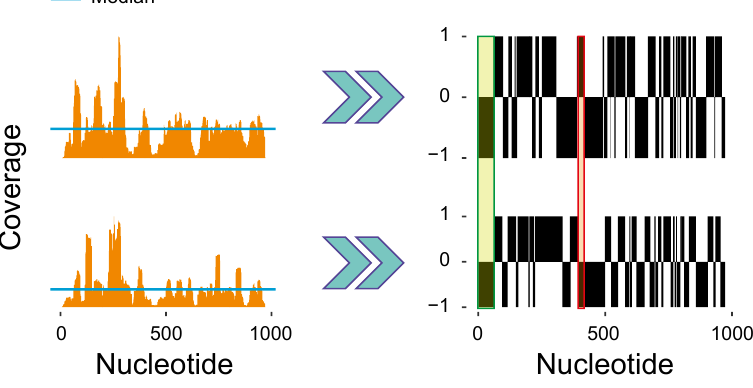
Figure 2. Pairwise comparison of two Ribo–seq profiles of the ispB gene. Two independent Ribo–seq profiles (left) are obtained by computing the coverage at each nucleotide position within the ORF. x-axis: position within the ORF (nucleotides); y-axis (top): relative coverage (number of mapping reads/total number of reads) mapping on the ORF. The Ribo–seq profiles are compared to the median coverage to produce the digitalized ± 1 profiles (right). The digitalized profiles can be easily compared to detect matches (e.g., green rectangle) and mismatches (e.g., red rectangle). The ratio between the number of matches and the total number of nucleotides in the ORF gives the matching score. A score equal to one means a perfect match between the two profiles, whereas a score equal to one-half means a poor matching